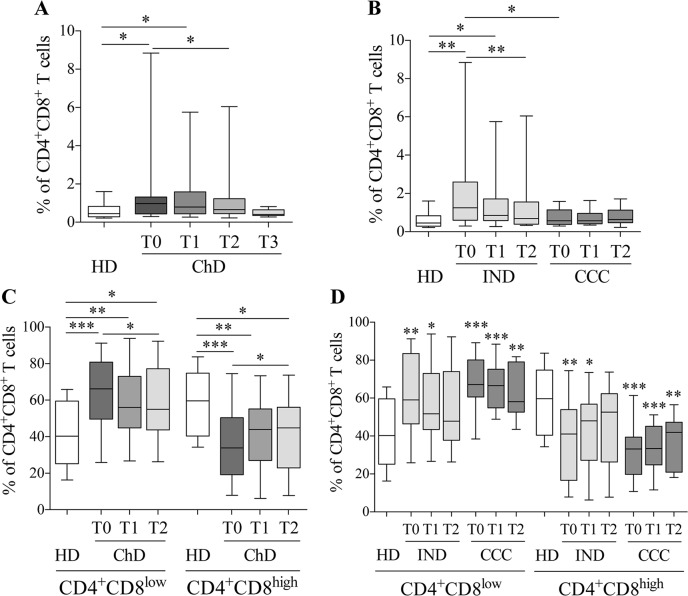
Percentage of circulating CD4+CD8+ T cells, CD4+CD8low and CD4+CD8high subpopulations pre and post treatment.Frequencies were evaluated at pre-treatment (T0) and at two times points after treatment: 9–12 months (T1) and 24–48 months (T2) in cChD patients (IND and CCC) and HD. (A) Follow-up of the CD4+CD8+ T cell frequency in HD and cChD after benznidazole treatment. (B) Frequency of CD4+CD8+ T cells in HD, IND and CCC before and after treatment. (C) Frequencies of CD4+CD8low and CD4+CD8high T cells were evaluated at the times points indicated in cChD and HD. (D) The percentages of the subpopulations of CD4+CD8+ T cells (CD4+CD8low and CD4+CD8high) were assessed before and after treatment in IND, CCC and HD. The statistical symbols (*) above the whiskers correspond to differences between HD and cChD at the different time points assessed. Statistical analyses were carried out using the Mann-Whitney U test and Wilcoxon test. Statistically significant differences are indicated by (*) ρ<0.05, (**) ρ<0.01 and (***) ρ<0.001. The study population was stratified by cChD (IND (n = 20), CCC (n = 18)) and HD (n = 12).